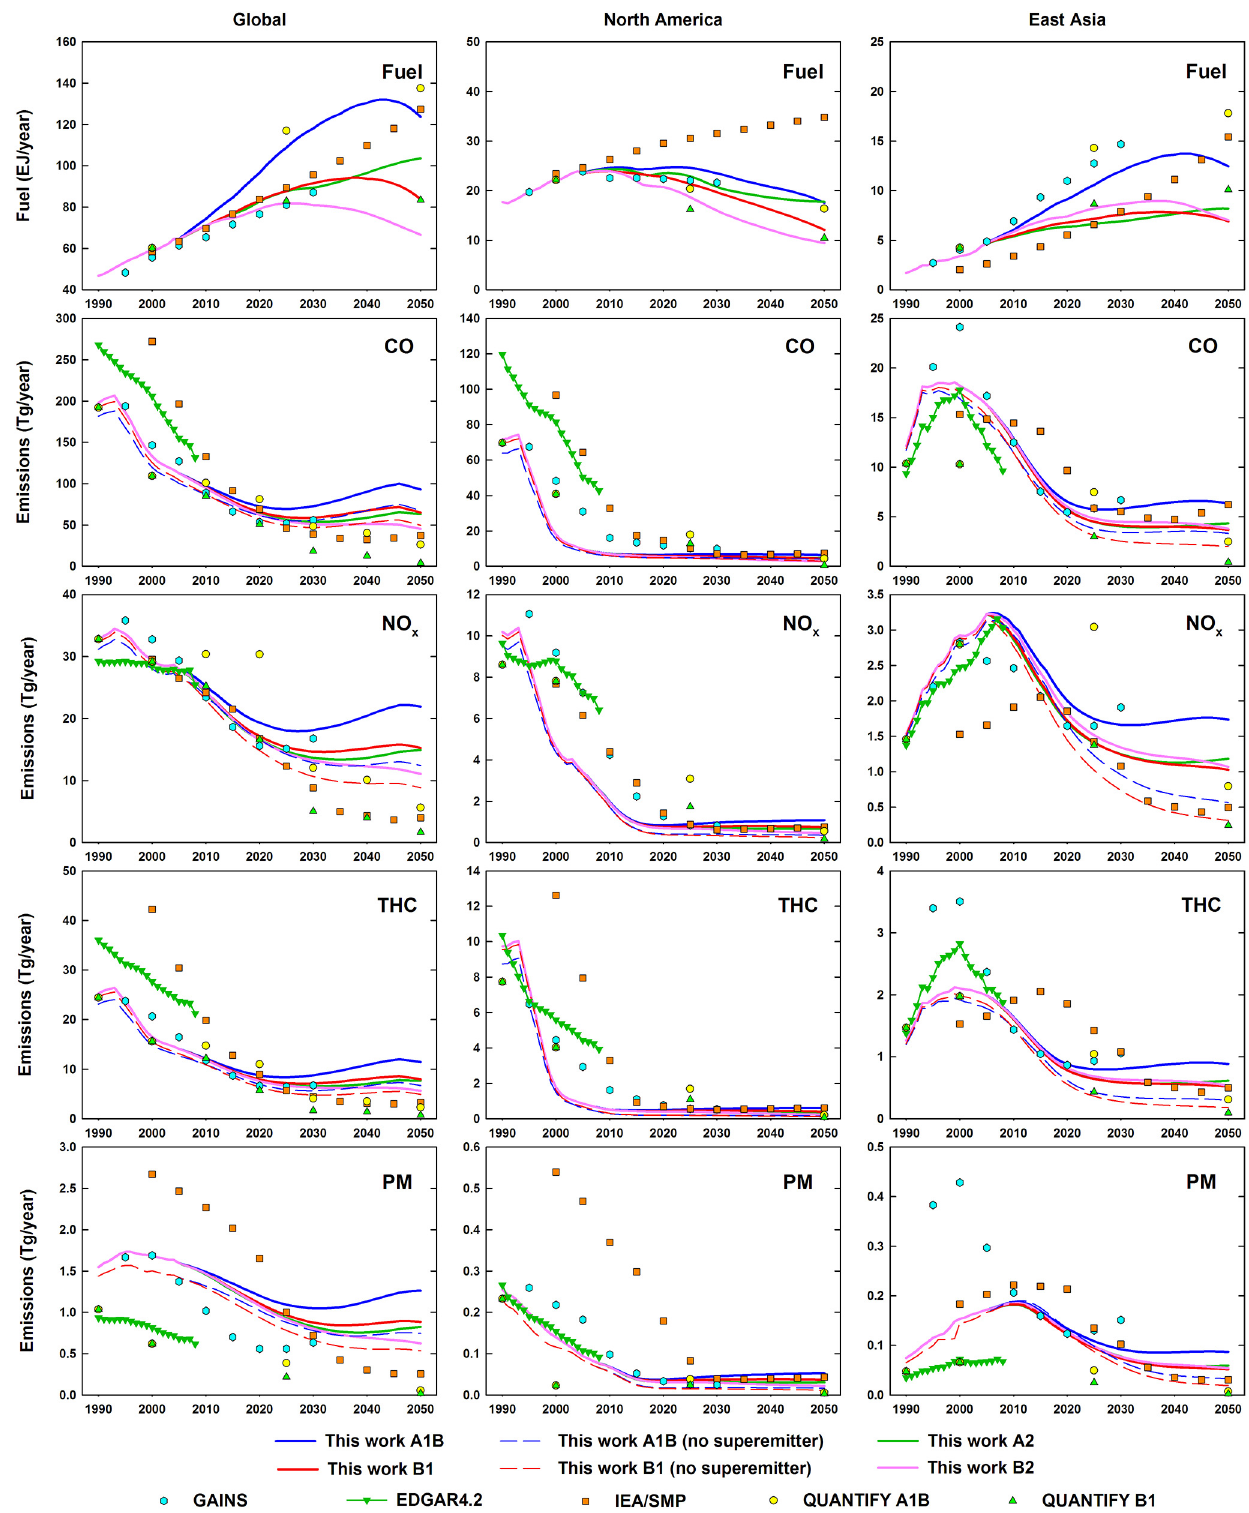
Figure 3. Comparison of global (left) and regional (North America, middle; East Asia, right) fuel and emission estimates for on-road vehicles in this work with previous studies: GAINS (scenario: BL_WEO_2010) (Klimont et al., 2009), EDGAR (version 4.2) (JRC/PBL, 2011), IEA/SMP (Fulton and Eads, 2004), and QUANTIFY (DLR,